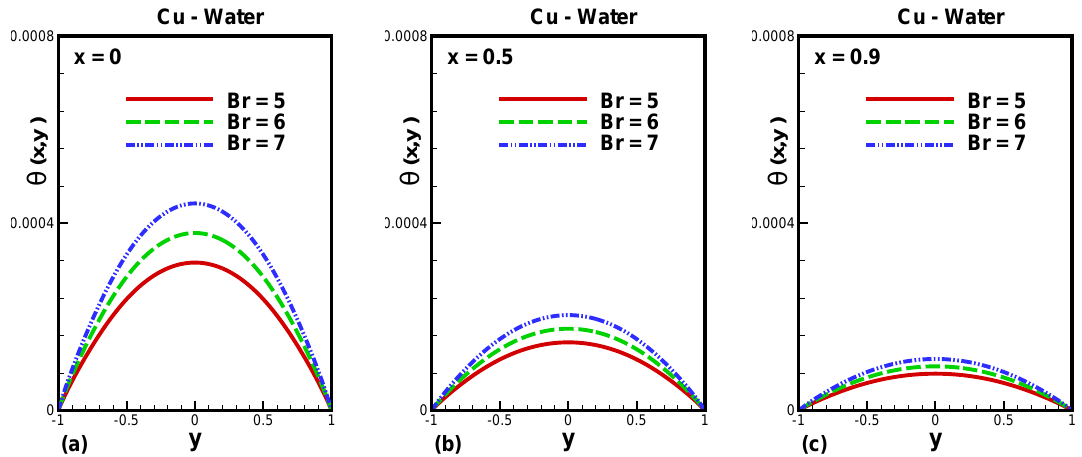
Figure 12. Effect of B r on dimensionless temperature distribution at the ( a ) entrance, ( b ) middle, and ( c ) exit regions of the channel, when φ = 0.05, δ = 0.2, P e = 1, β = 0.5, δ = 0.2, and γ =